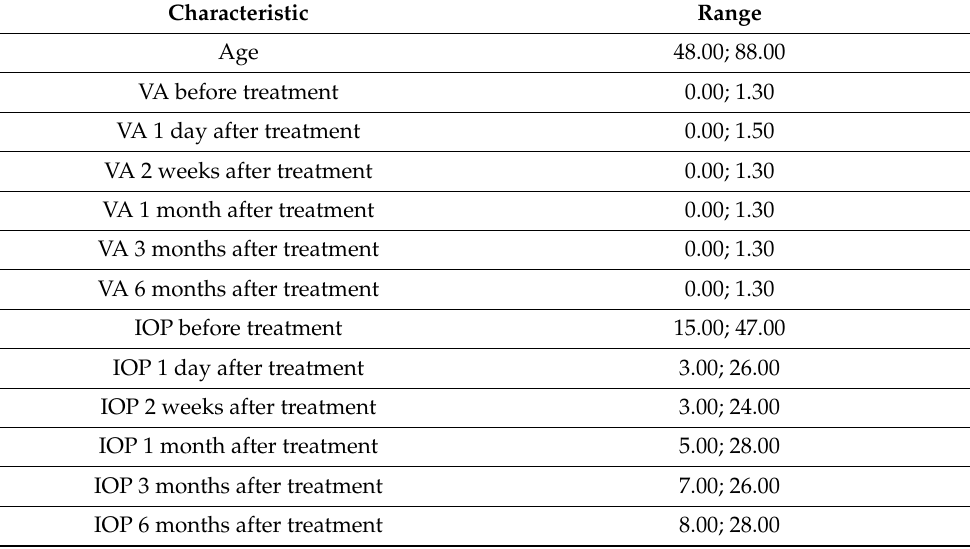
Table 4. Range of